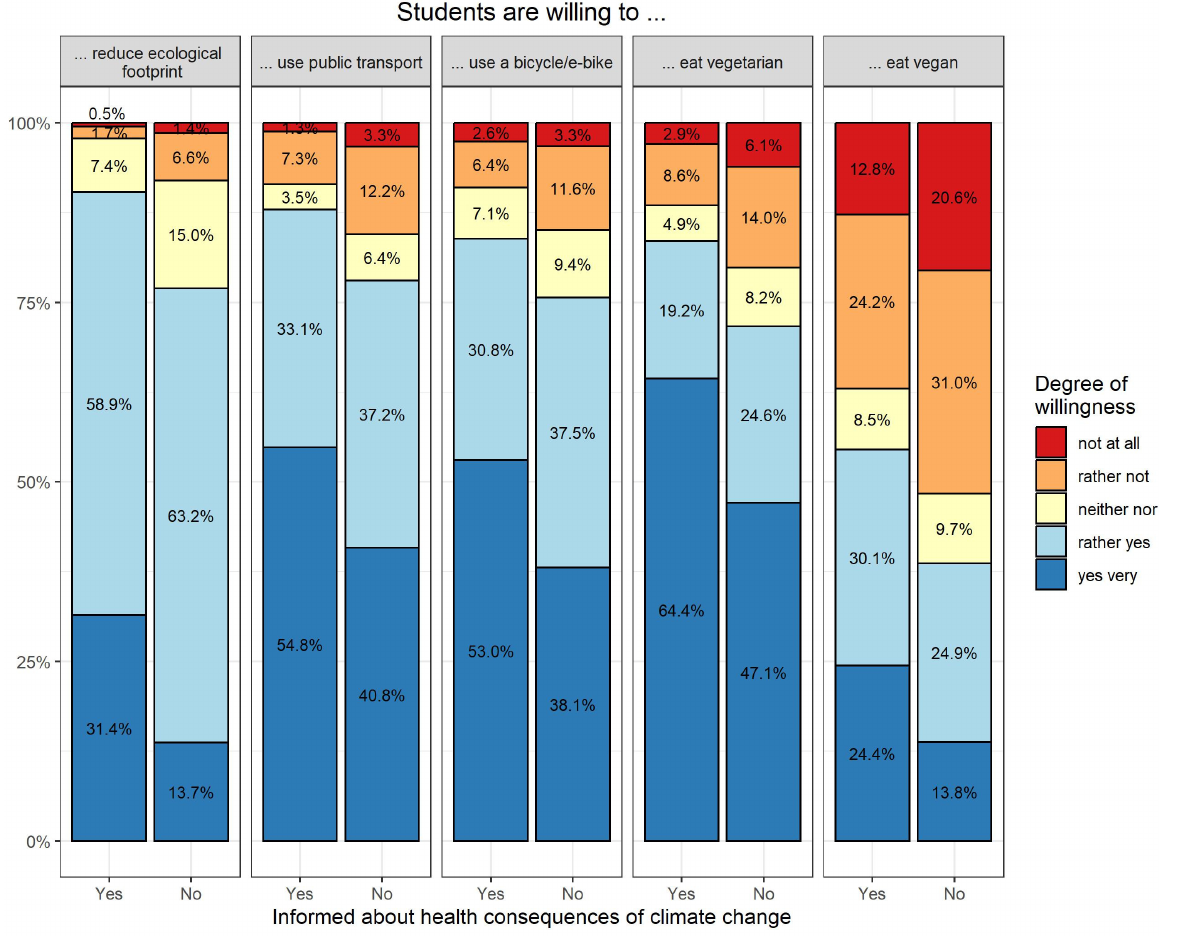
Figure 1. Willingness to engage in sustainable behaviors, stratified by informedness about the health consequences of climate change ( n = 3052).